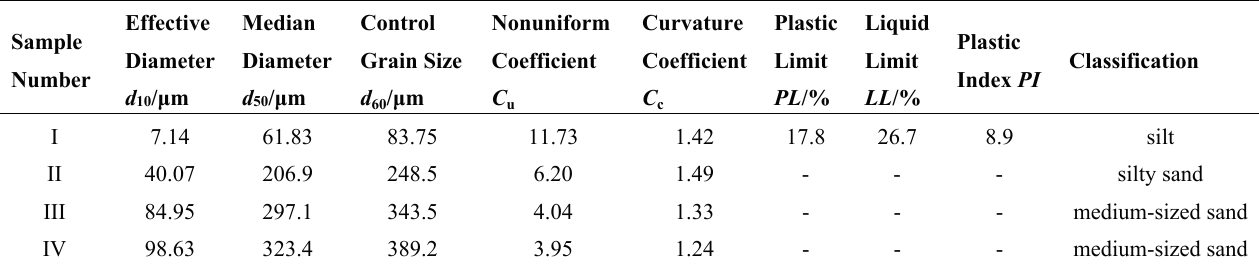
Table 5. PSD parameters of the tailings post-test.